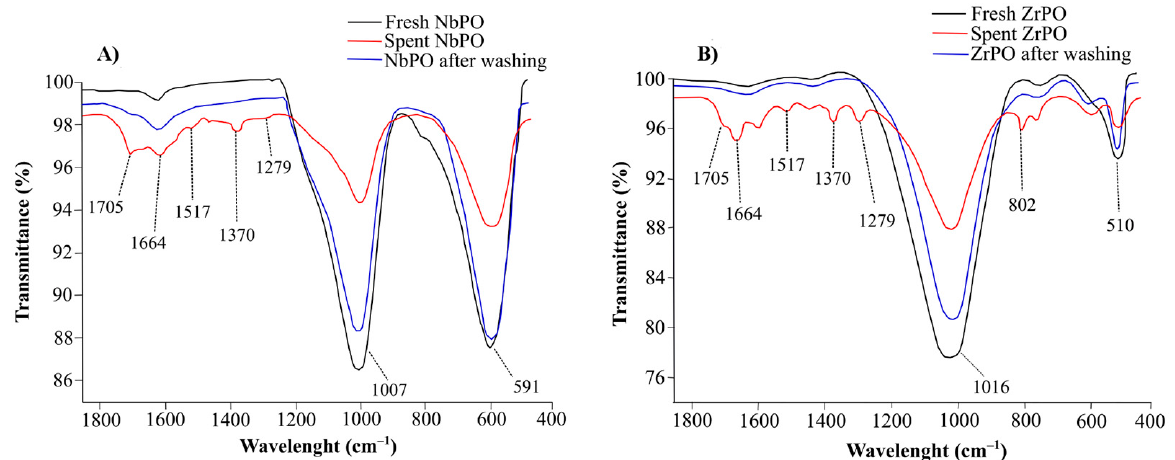
Figure 4. Comparison between FT-IR spectra of fresh NbPO and ZrPO catalysts, spent catalysts and catalysts after washing reactivation in wavenumber range of 1850-430 cm − 1 : ( A ) NbPO and ( B ) ZrPO.